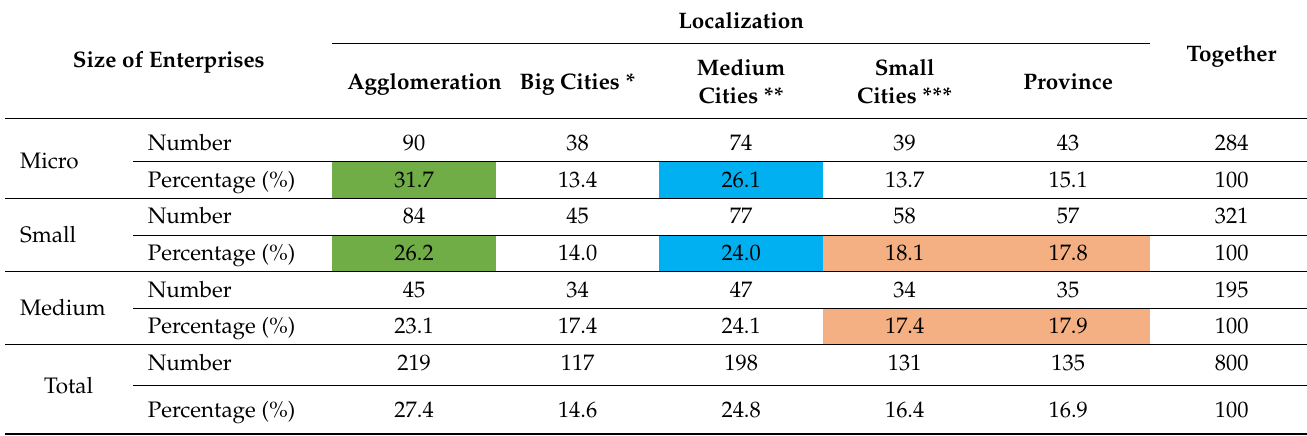
Table 3. Division of the study sample by location.